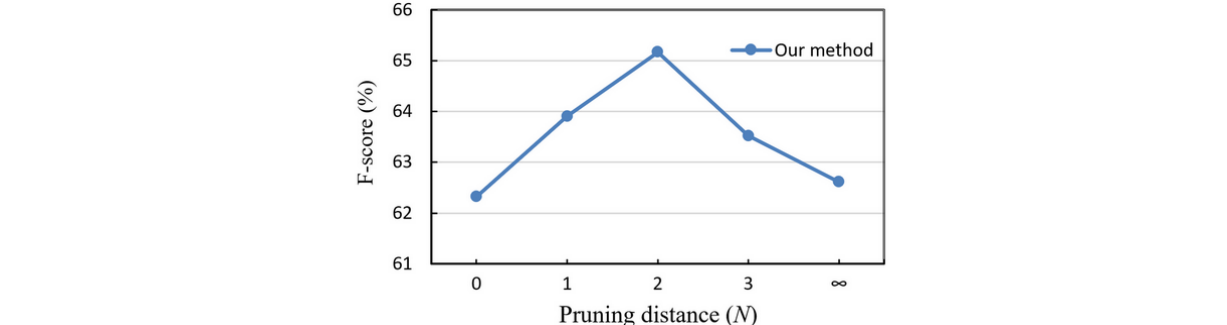
Figure 4. Comparison of different pruning distances.